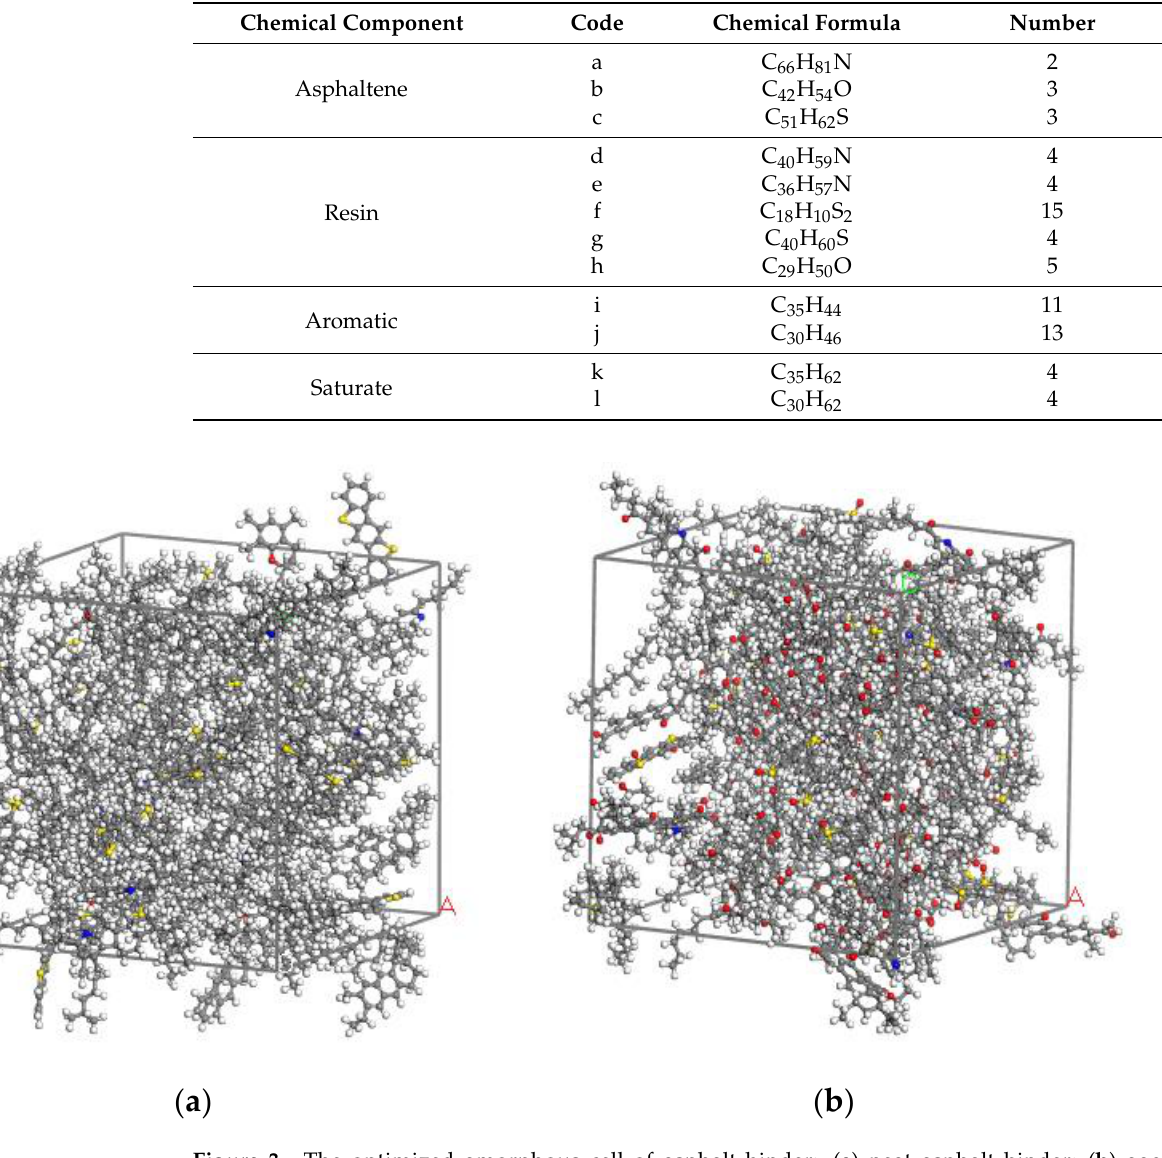
Figure 3. The optimized amorphous cell of asphalt binder: ( a ) neat asphalt binder; ( b ) aged asphalt binder. Table 1. Chemical components in the amorphous cell of asphalt binder.